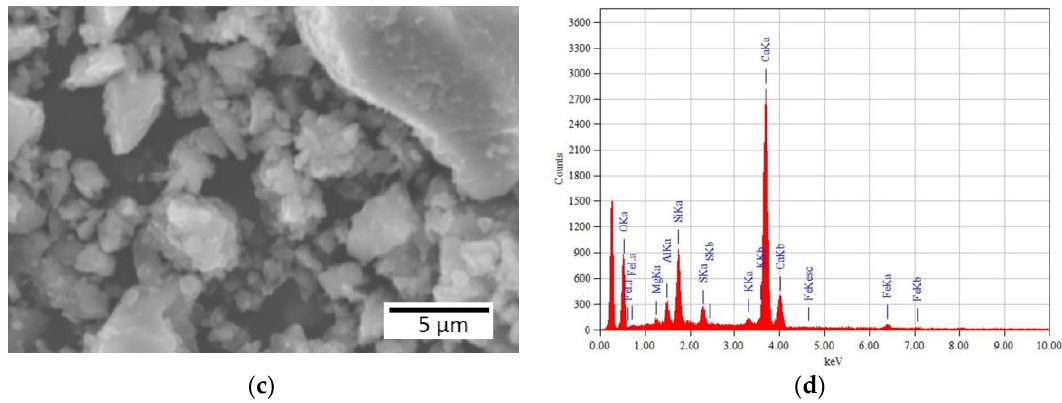
Figure 2. Morphology ( a , b , c ) and X-ray diffraction spectrum of the cement used to make the substrate ( d ).